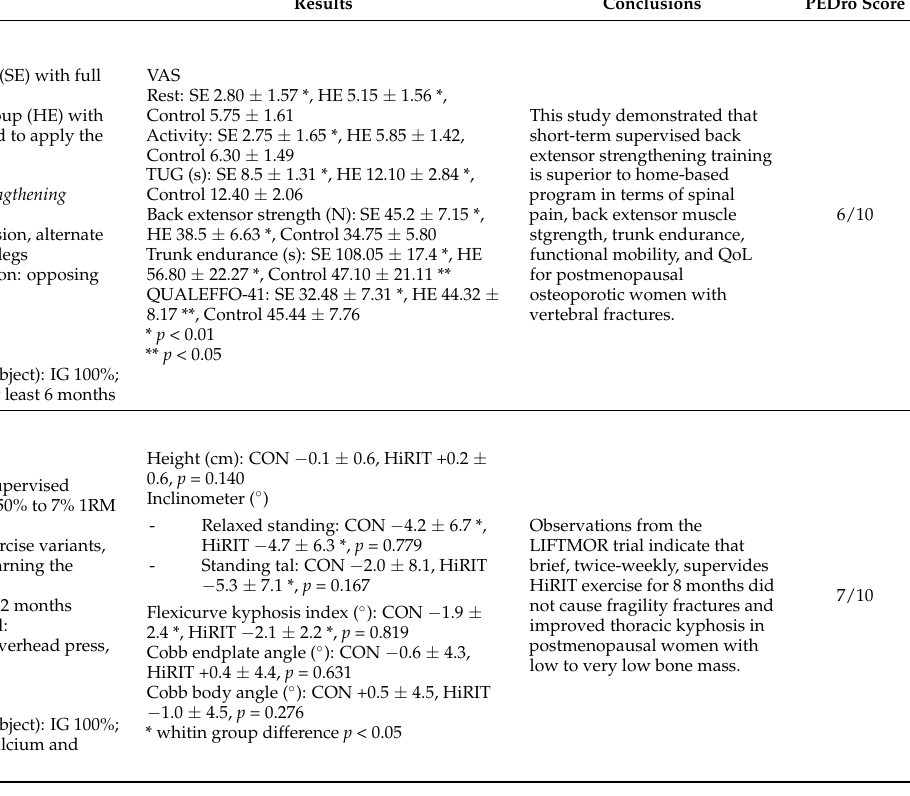
Protocol duration: 6 weeks Frequency: 3 times per week IG: Supervised exercise group (SE) with full supervision of